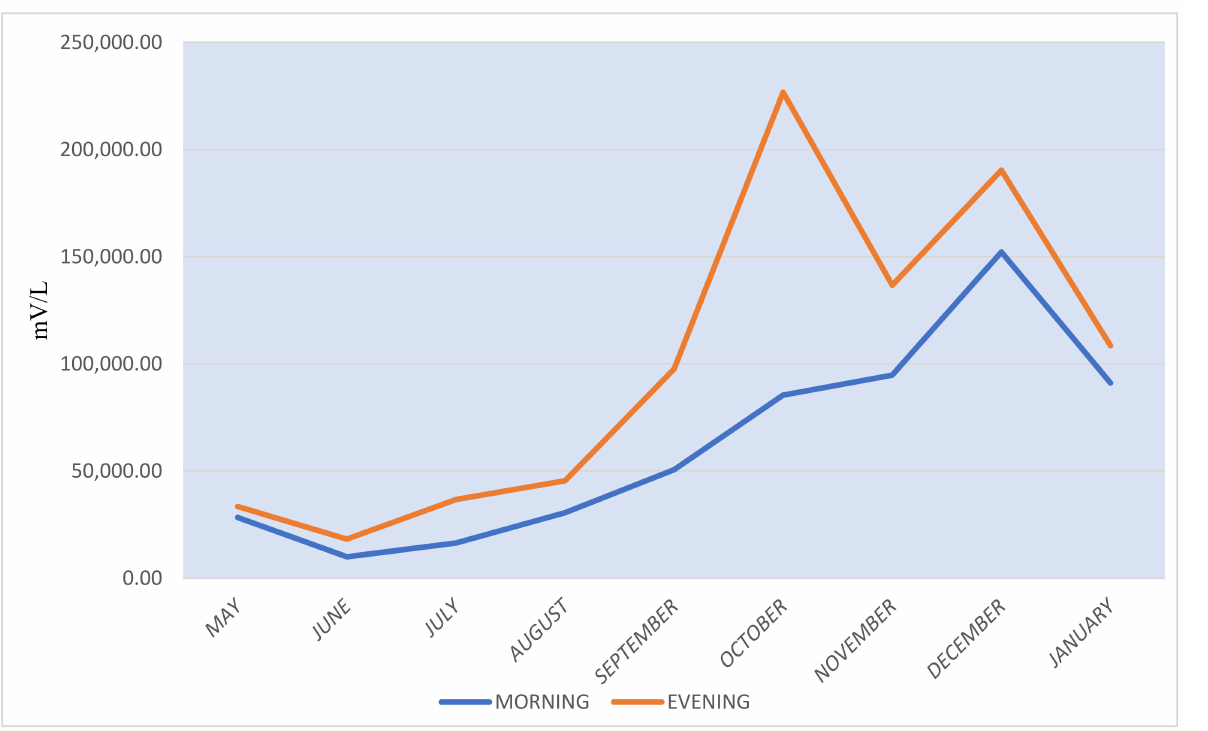
Figure 2. Schematic representation of the seasonal variation of the mean values of the ALP activity in raw goat’s